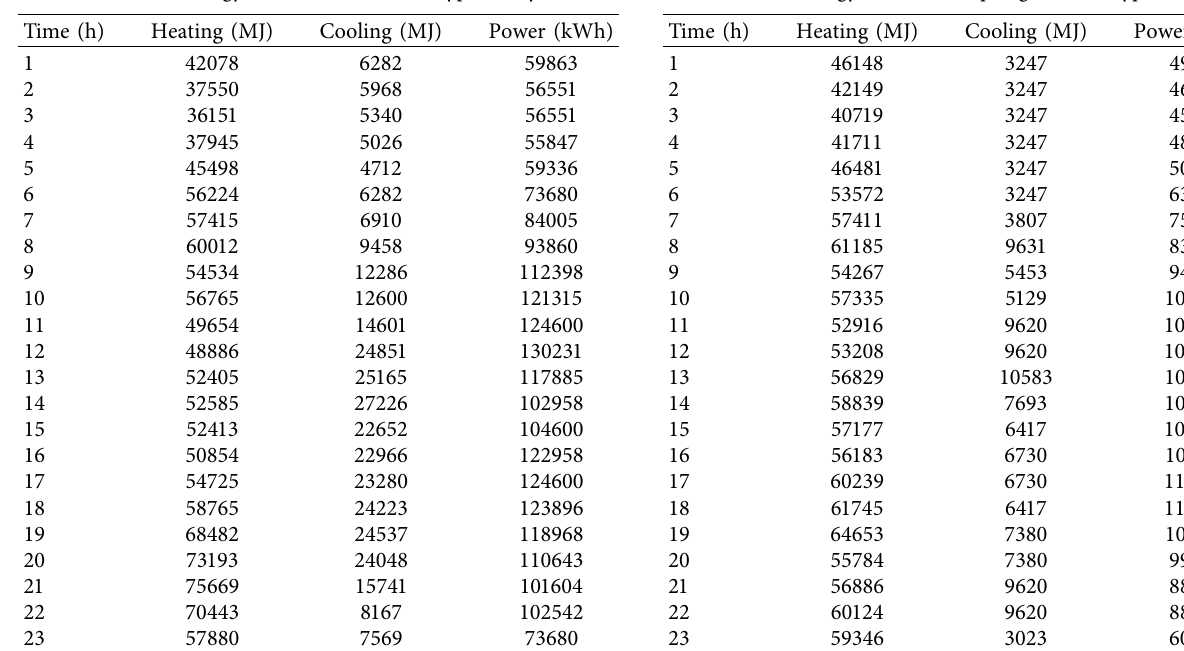
Table 1: Energy demand of summer typical day.